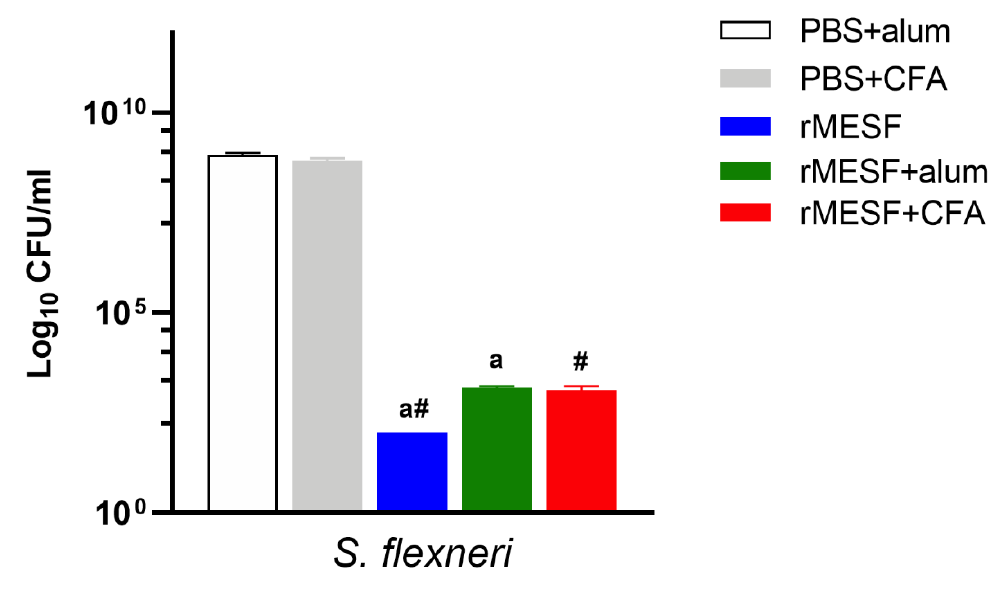
Figure 8. Bacterial burden in lungs after challenge assay of control and immunized mice. Lungs were collected from survival mice and controls groups after 30 days and three days, respectively, of challenge with lethal dose of S. flexneri (1 × 10 7 CFU/mouse), and bacterial loads were determined by 10-fold serial dilutions on LB agar plates incubated at 37 °C for 18 h. Symbols and Letters indicate statistically significant values of p < 0.0001 compared with the respective mice group. # vs. PBS+CFA, a vs. PBS+alum. PBS, phosphate-buffered saline. CFA, complete Freund’s adjuvant. CFU, colony forming units; i.n., intranasally.